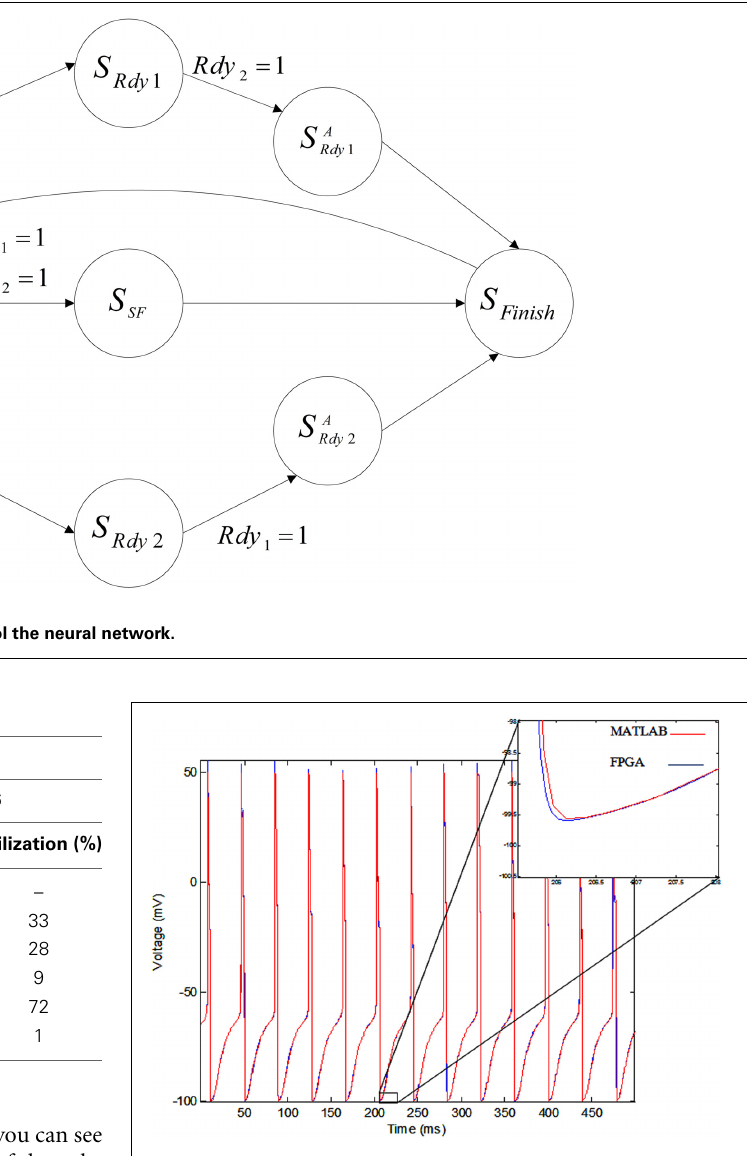
FIGURE 11 | The voltage of single neurons, implemented single neuron (blue line) and MATLAB simulation (red line).